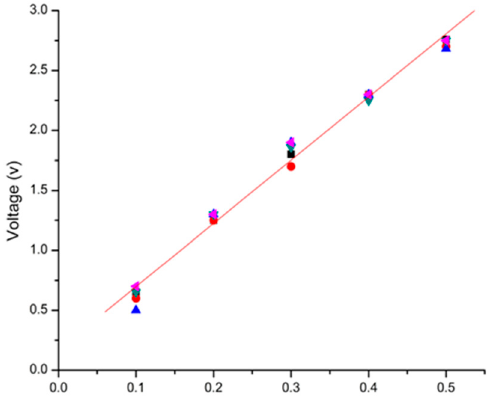
Figure 9. Displacement–voltage response of the sensor.